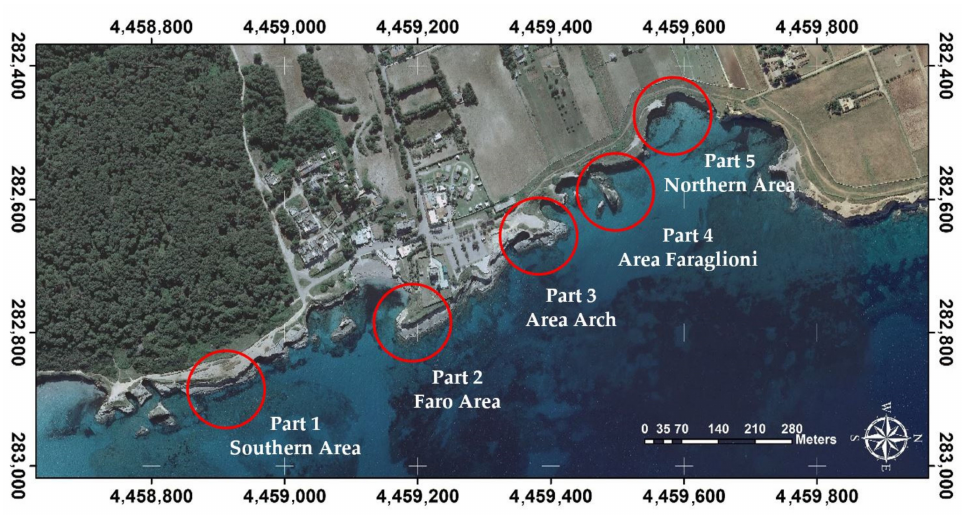
Figure 7. Identification of the five detailed